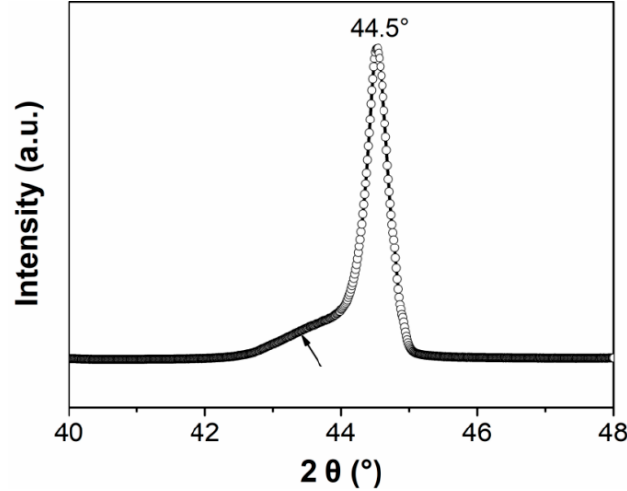
Figure 3. X-ray diffraction (XRD) profiles of the PZN-7%PT single crystal.